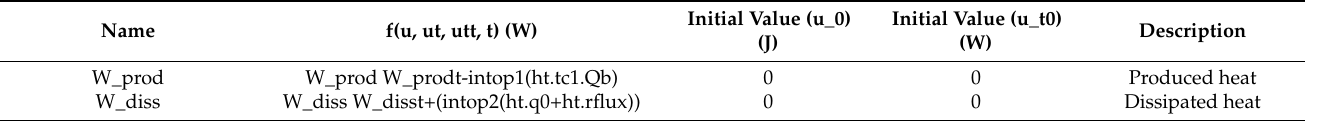
Table 4. Global equations for the two brake systems.